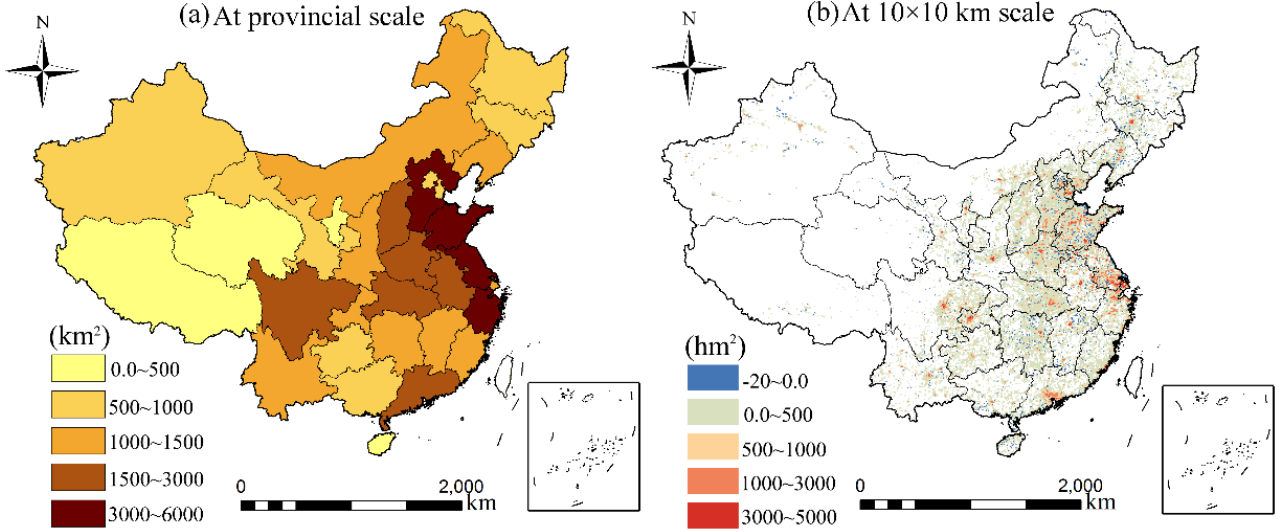
Figure 3. Spatial distribution of the loss of farmland area due to urban land sprawl from 2000 to 2020.